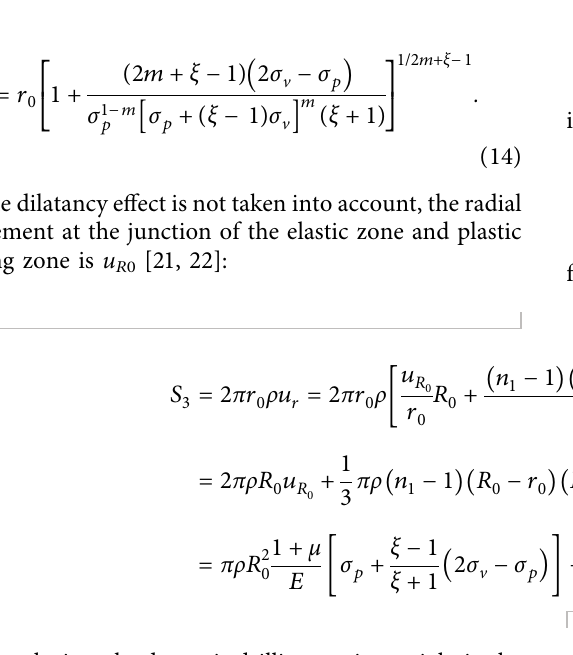
Figure 4: Mechanical model for plane strain surrounding the drilling hole in the elastic